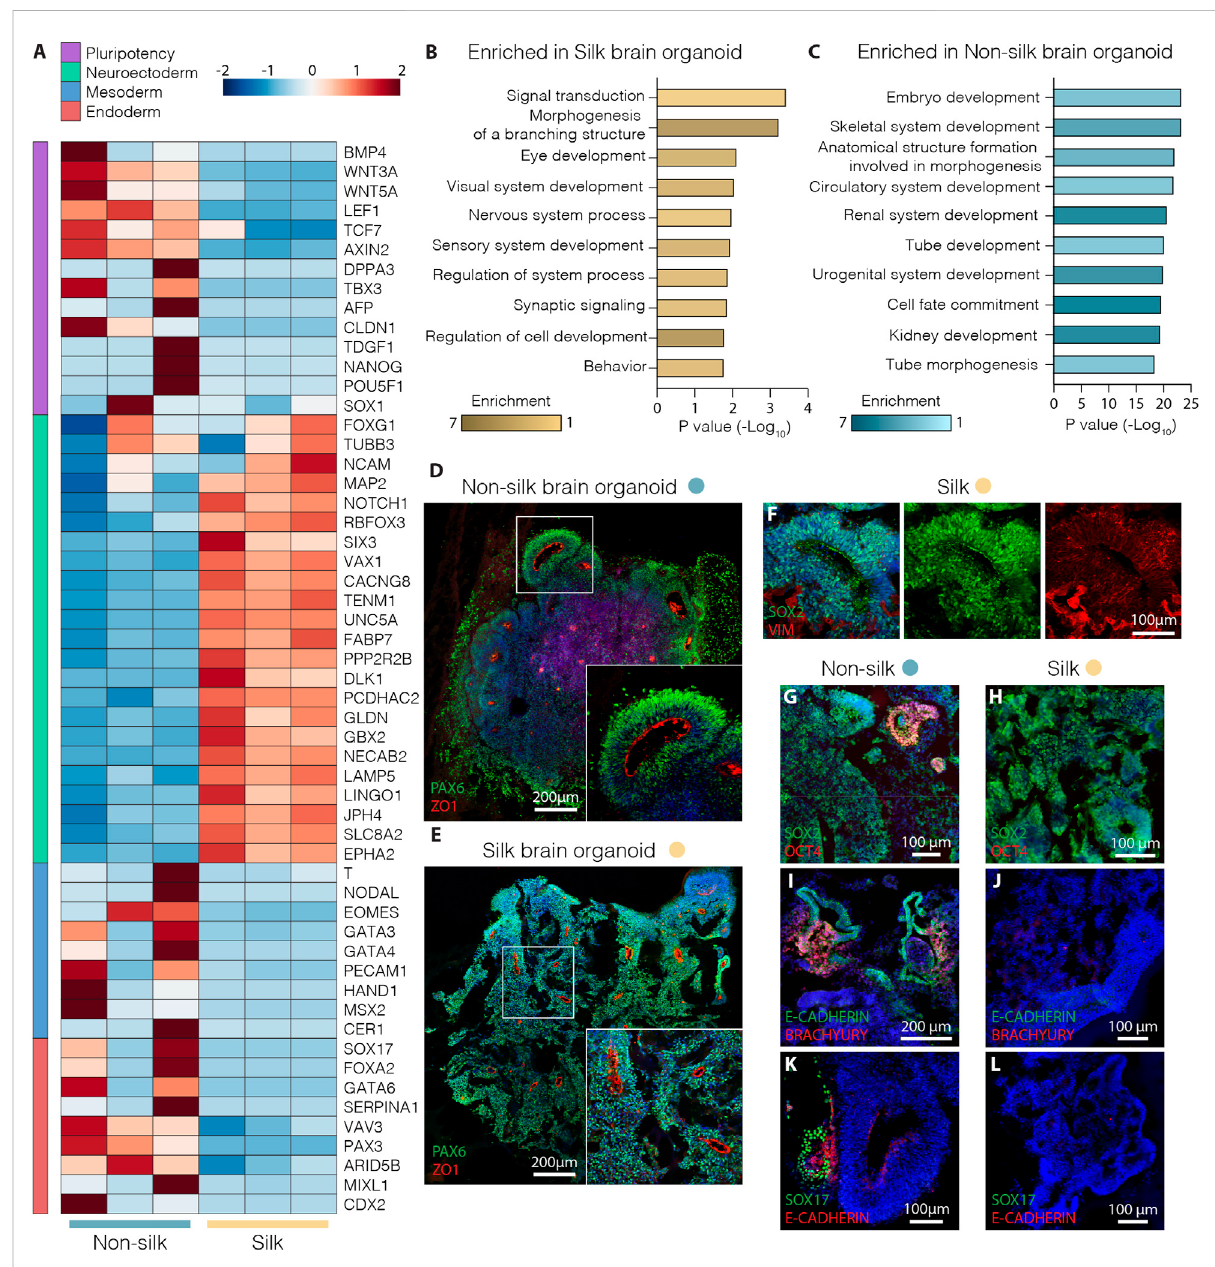
FIGURE 2 Silk cerebral organoids display enhanced neurogenesis. (A) Heat map showing expression levels of selected differentially expressed genes (DEG) considered markers of pluripotency andneuroectoderm, meso-endoderm differentiation in three biological replicates of silk and non-silk human brain organoids at day 20. (B,C) Enrichment of top ten biological process gene ontology terms ordered by p -value of upregulated genes in (B) silk and (C) non-silk brain organoids at day 20. (D,E) Immunohistochemistry of PAX6 and ZO1 showing neural rosettes in non-silk (D) and silk brain organoid (E) at day 20. Scale bars 200 µm. (F) Cryosection of silk brain organoid at day 20 showing